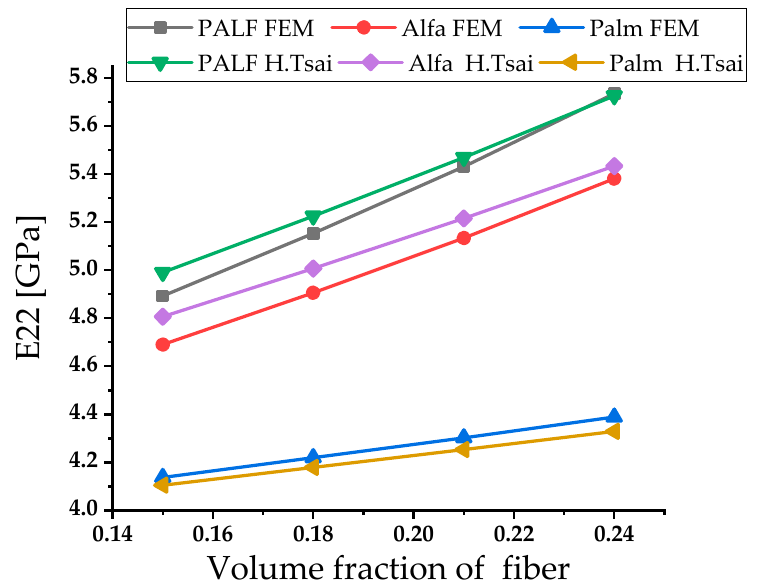
Figure 12. Predicted analytical (Halpin–Tsai model) and numerical results for E 22 in terms of V F .